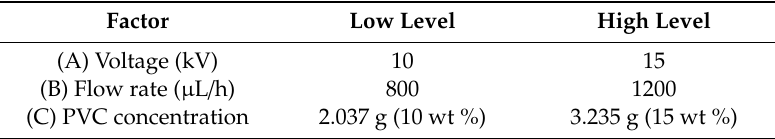
Table 5. Design of experiments (DoE) with the factors evaluated with their corresponding low and high level.